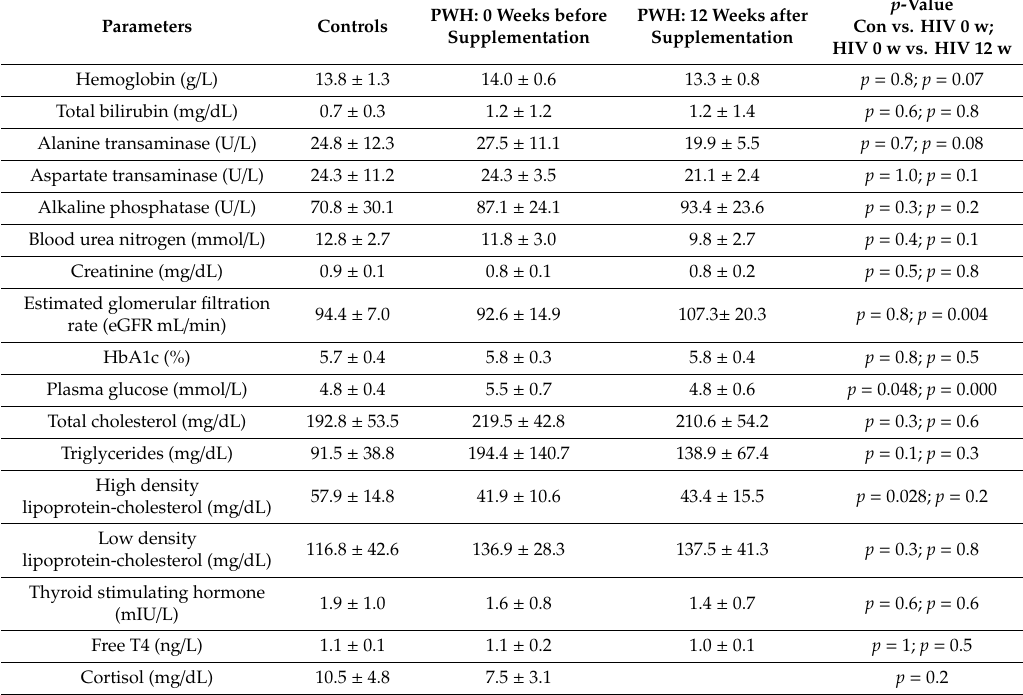
Table 1. Serum biochemistry before and after supplementation with glycine and N-acetylcysteine (GlyNAC). ‘Controls’ (Con) = uninfected participants not on supplementation; ‘patients with HIV (PWH): 0 weeks’ = HIV participants studied before receiving supplementation with GlyNAC; ‘PWH: 12 weeks’ = HIV participants studied 12 weeks after receiving supplementation with GlyNAC. Values are means ± SD; means are significantly di ff erent at p < 0.05.